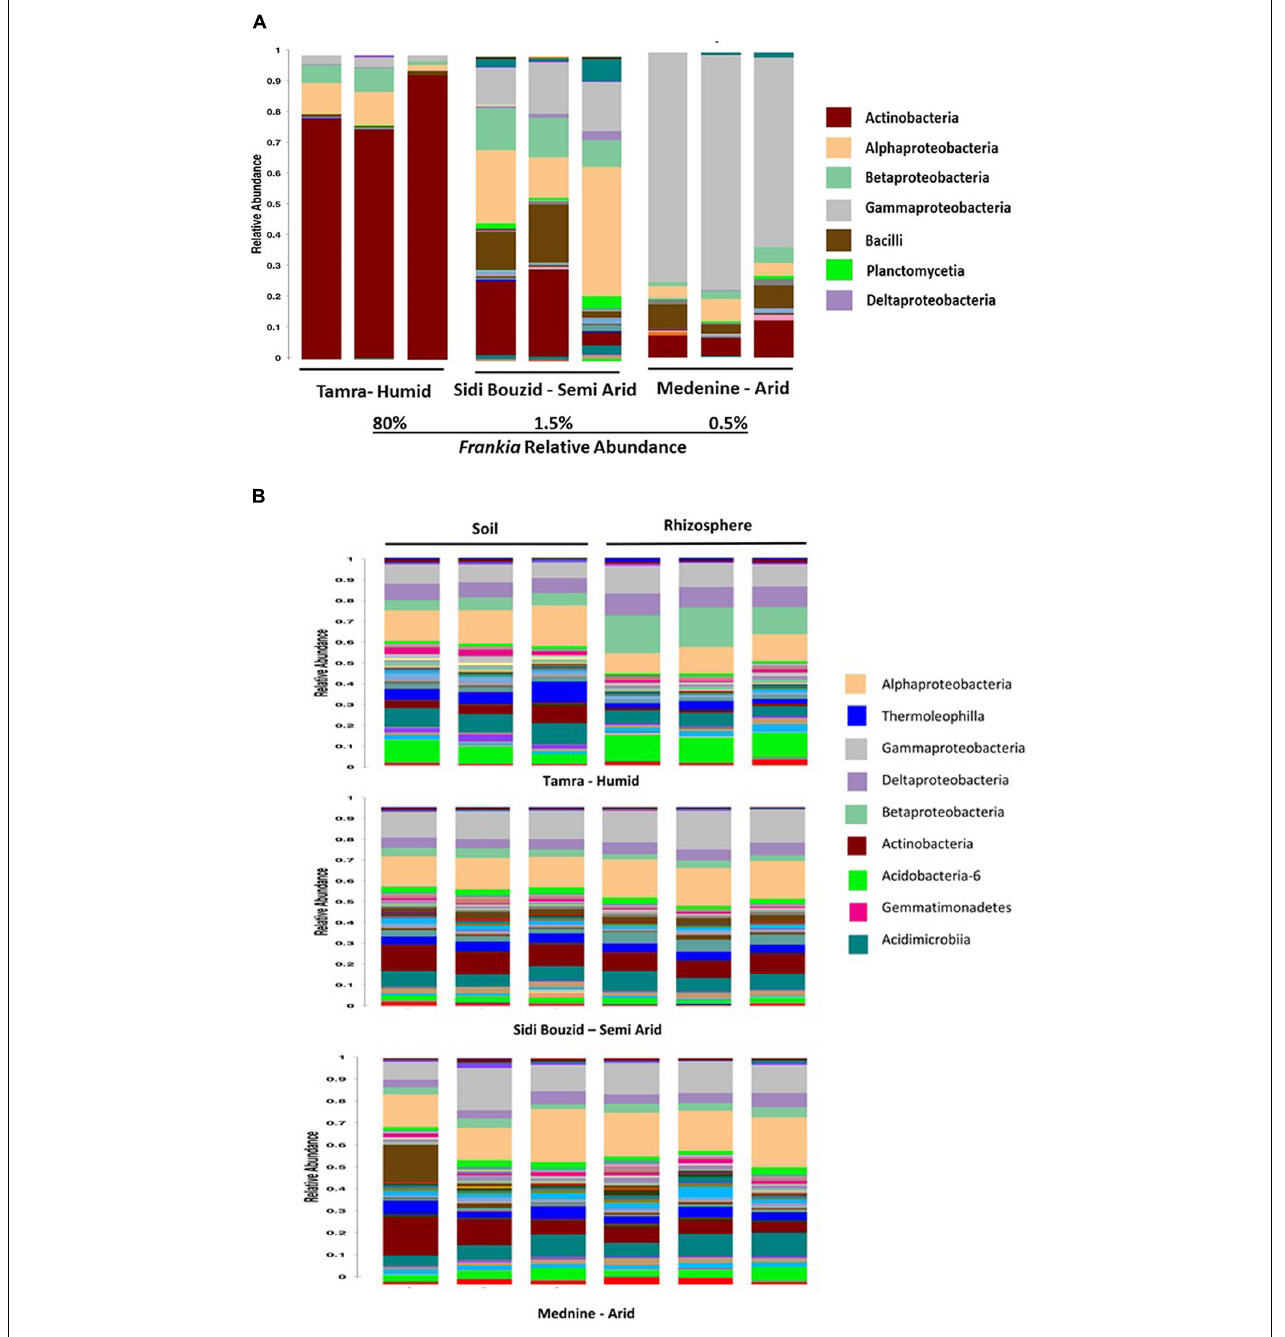
FIGURE 3 | Class level taxonomic summary of nodule, Rhizosphere and soil samples. (A) Nodules grouped by site. The relative abundance of the nodule samples was summarized at the class level after corrected for 16S operon copy number variation. The humid and arid samples are significantly less diverse than the semi-arid samples, as can be seen in (A) . This can be seen here, as the humid site is dominated by Actinobacteria (the genus Frankia ), and the arid site is dominated by Acinetobacter and Pseudomonas. (B) Rhizosphere and soil samples grouped by sampling site. These charts show relative abundance of taxa at the class level after correction for 16S operon copy